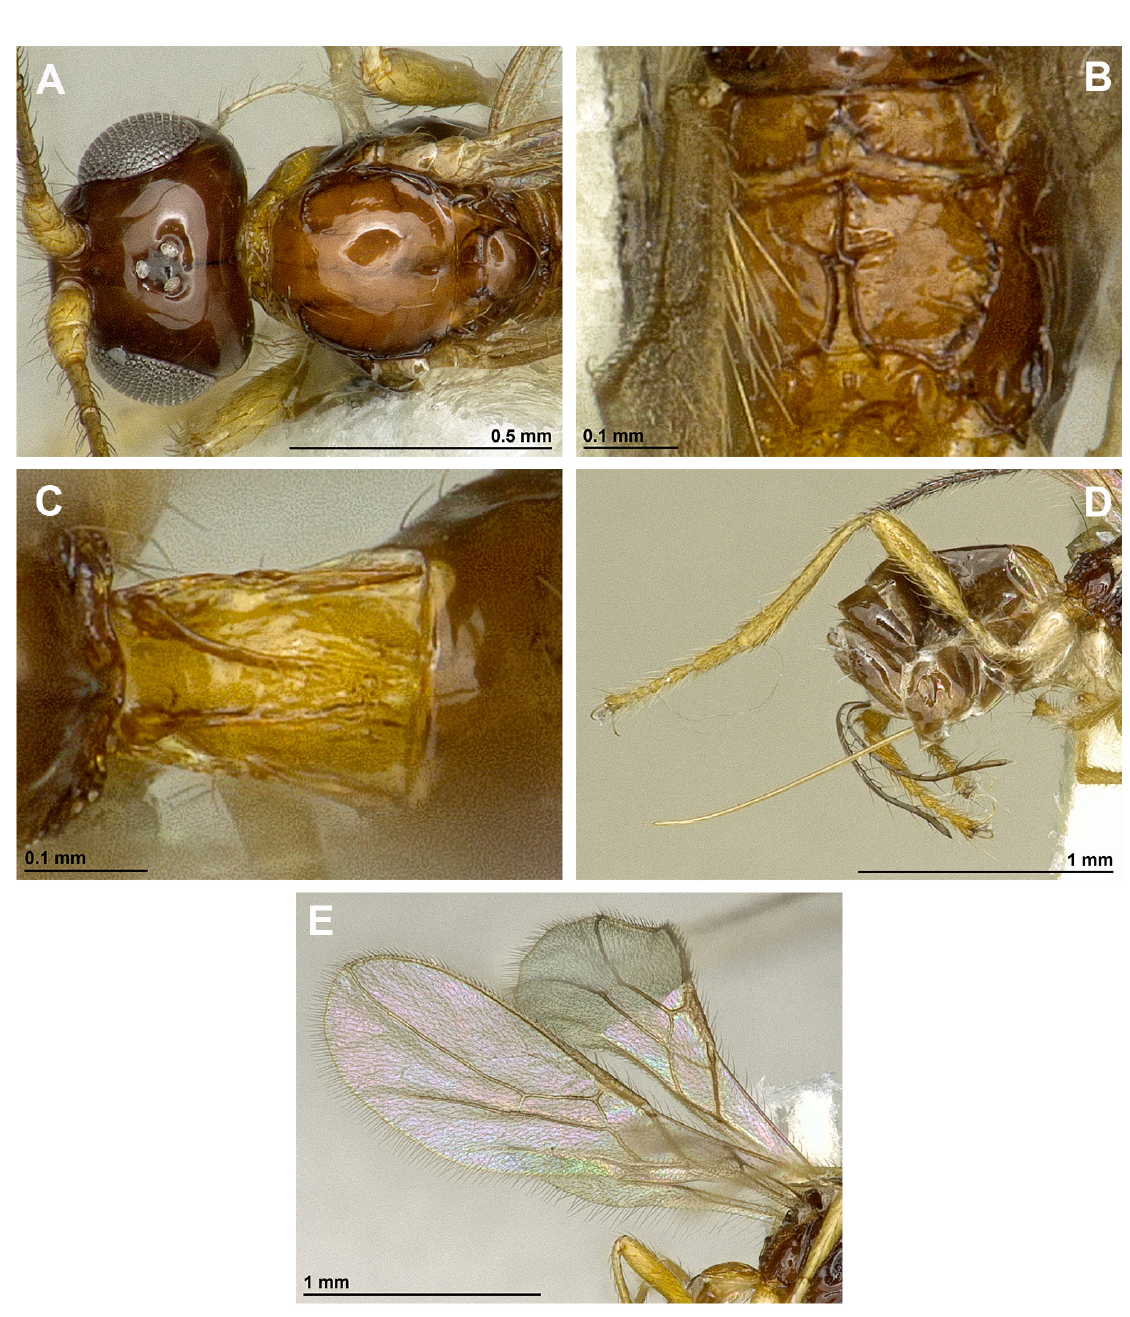
Fig. 10. Asobara citri (Fischer, 1963), ♀, holotype (NHMW). A . Head and mesoscutum, dorsal view. B . Propodeum, dorsal view. C . First metasomal tergite, dorsal view. D . Hind leg, metasoma and ovipositor, lateral view. E . Fore and hind